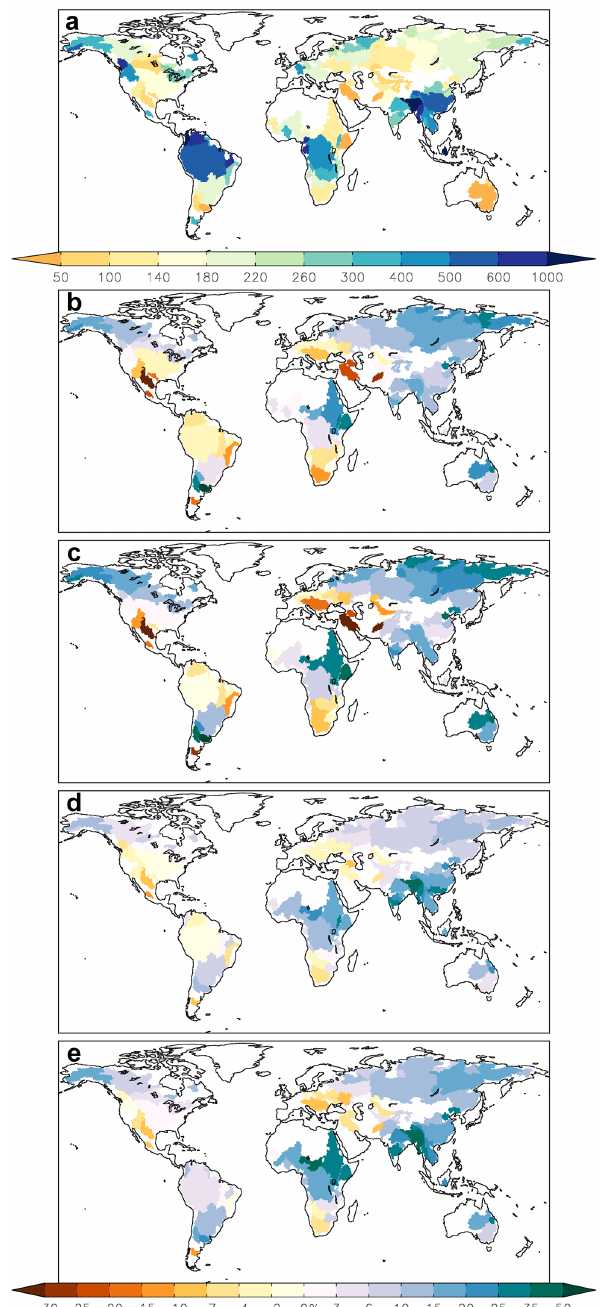
Figure 10. (a) Annual average runoff (kgm 2 ) for the 100 largest river basins. (b) Changes (%) from historical to the RCP4.5 case and (c) the RCP8.5 case. (d) Percentage change in the IASD of monthly mean runoff averaged for all months from historical to the RCP4.5 case and (e) the RCP8.5 case.